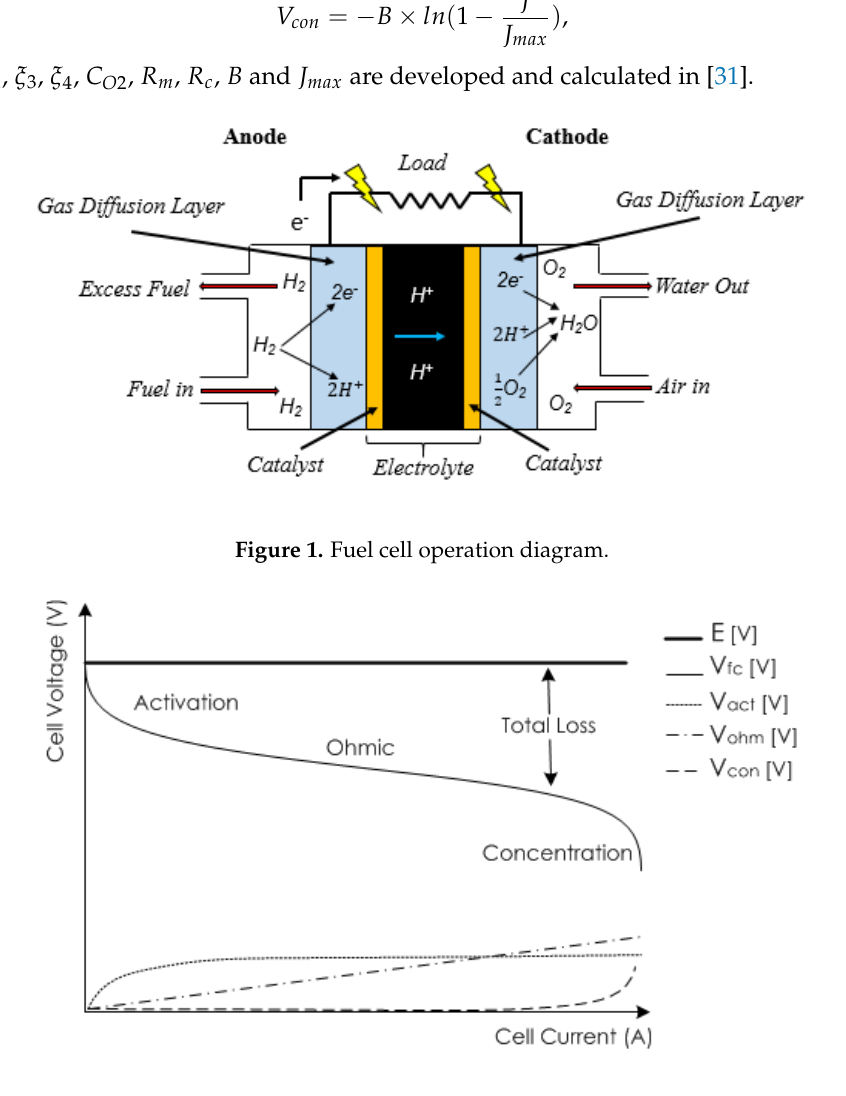
Figure 2. Ideal and actual fuel cell voltage/current